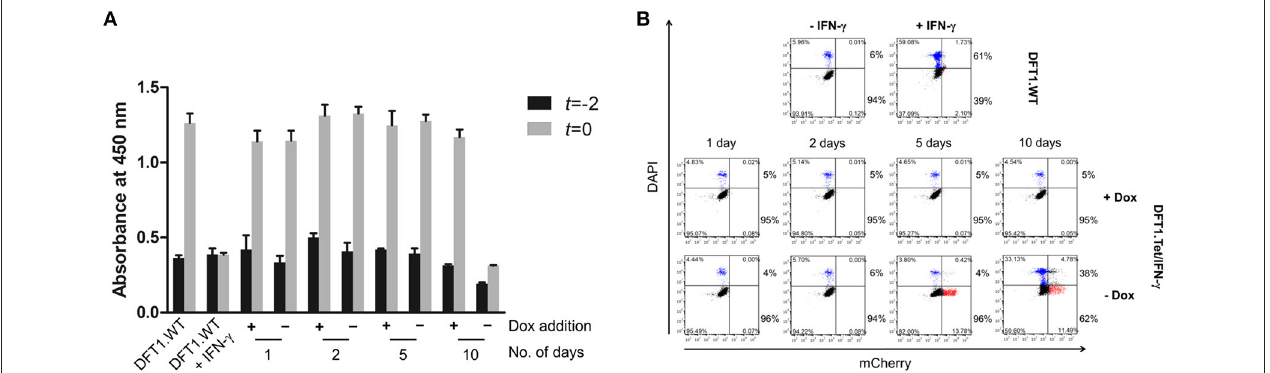
FIGURE 4 | Anti-proliferative and pro-apoptotic effects of IFN- γ are ameliorated in DFT1.Tet/IFN- γ cultured with doxycycline. Cell proliferation and viability of DFT1.Tet/IFN- γ was compared against DFT1.WT cells cultured with or without 50ng/ml IFN- γ for 10 days. (A) Differences in proliferation of DFT1.Tet/IFN- γ in the presence and absence of doxycycline for 1, 2, 5, and 10 days, assessed by WST-8 proliferation assay. The WST-8 assay uses absorbance at 450nm as a proxy for the number of viable cells. Baseline absorbance was measured 2 days prior ( t = − 2) and change in absorbance was measured after 2 days ( t = 0). Graph shows the average value of triplicates and a standard deviation error bar. (B) Cell viability of DFT1.Tet/IFN- γ in the presence and absence of doxycycline for 1, 2, 5, and 10 days. Cell death over 2 days (from t = − 2 to t = 0) was quantitated by staining dead cells with DAPI and analysis by flow cytometry. The results shown are representative of n = 3 replicates/treatment. The percentages in the upper right and left quadrants were added to yield the total percentage of dead cells while the same was done for the lower quadrants to give the total percentage of viable